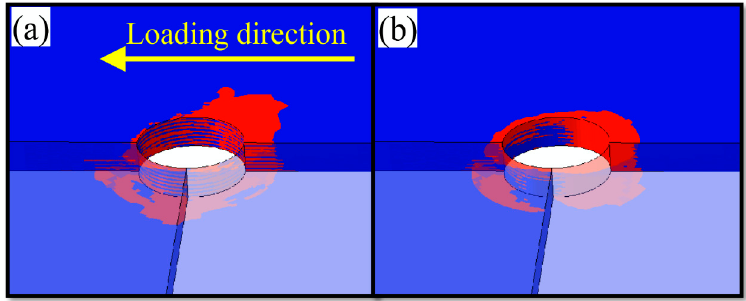
Figure 12. FEM results of hole circumference at C (( a ) fiber kinking, ( b ) matrix damage).